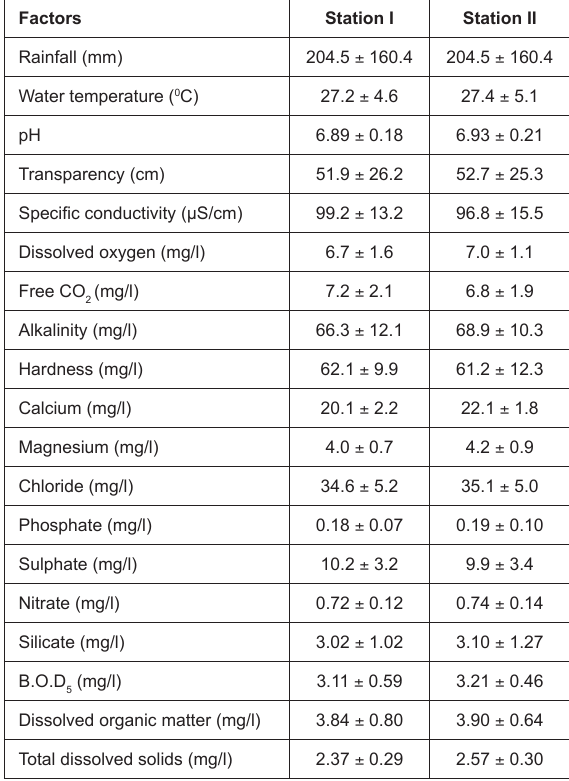
Table 1. Temporal variations of abiotic